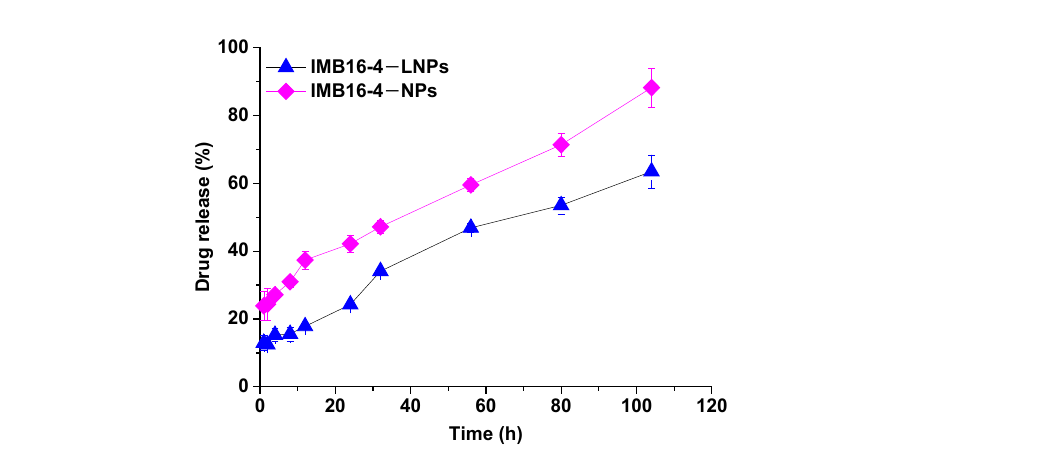
Figure 4. The release of IMB16-4–LNPs and IMB16-4–NPs was carried out by the dialysis method. IMB6-4–NPs were used as control. Then, 1 mL of IMB16-4–LNPs or IMB16-4–NPs containing 0.25 mg IMB16-4 was sealed in dialysis bags and submerged in 50 mL of PBS buffer solution (pH 7.4). Data are presented as mean ± SD ( n = 3).